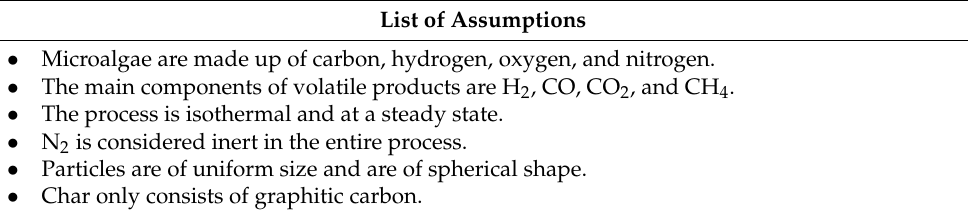
Figure 2. Aspen Plus flowsheet simulation of the cogeneration process of methanol and electricity from microalgae biomass. Table 4. Assumptions for the biomass algae